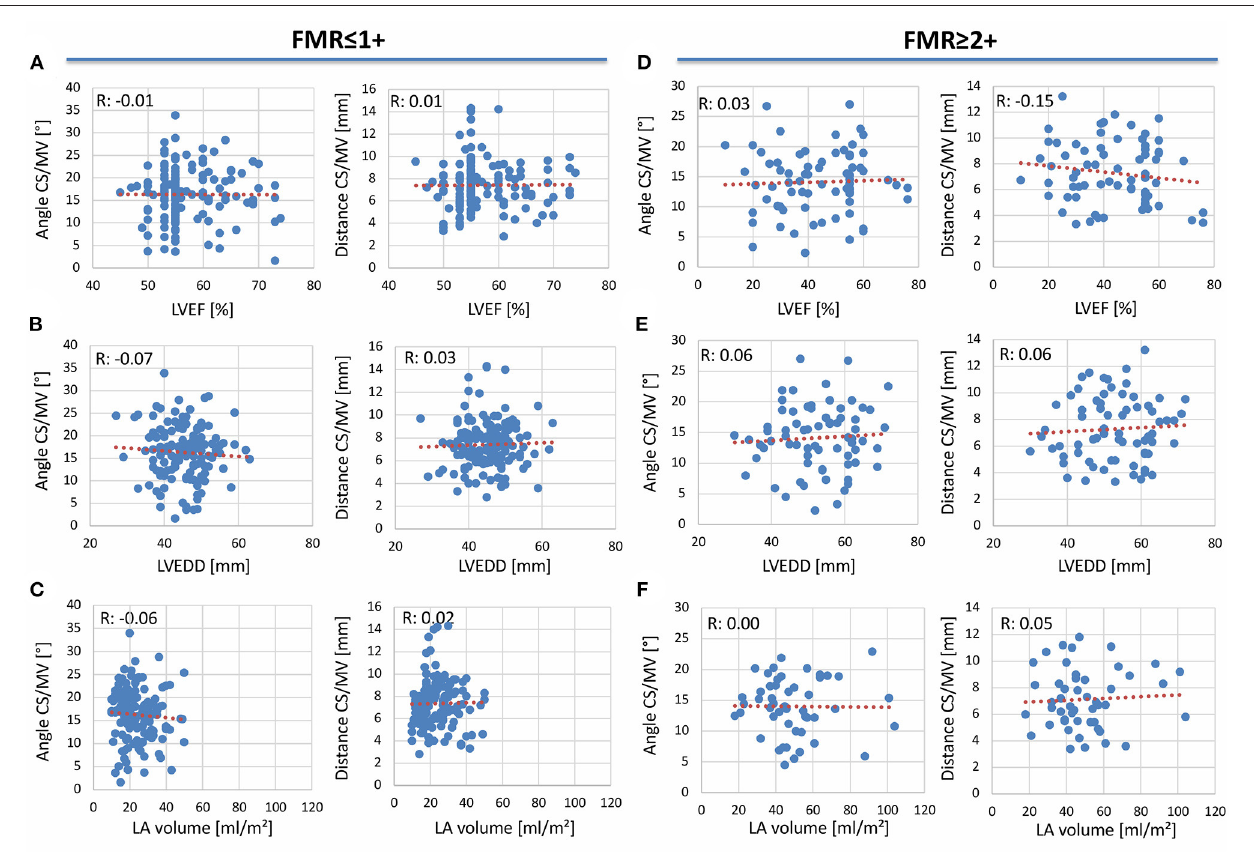
FIGURE 3 | Correlation of angulation and distance of CS to MVA planes with left ventricular ejection fraction left ventricular end-diastolic diameter and left atrial volume in patients with and without FMR. Correlation of angle (left) and distance (right) of the coronary sinus (CS) to mitral valve annulus (MVA) with (A) left ventricular ejection fraction (LVEF), (B) left ventricular end-diastolic diameter (LVEDD), and (C) left atrial (LA) volume in patients with FMR ≤ 1 + . Correlation of angulation (left) and distance (right) of CS to MVA with (D) LVEF, (E) LVEDD, and (F) LA volume in patients with FMR ≥ 2 + . R -values as indicated.